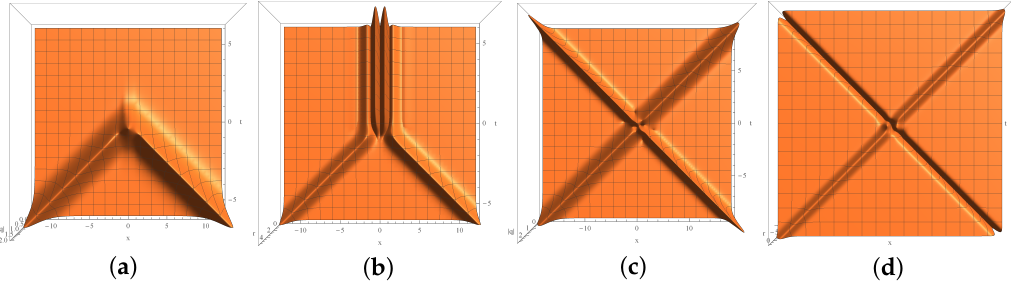
Figure 2. Inelastic ( a , b ) and elastic ( c , d )